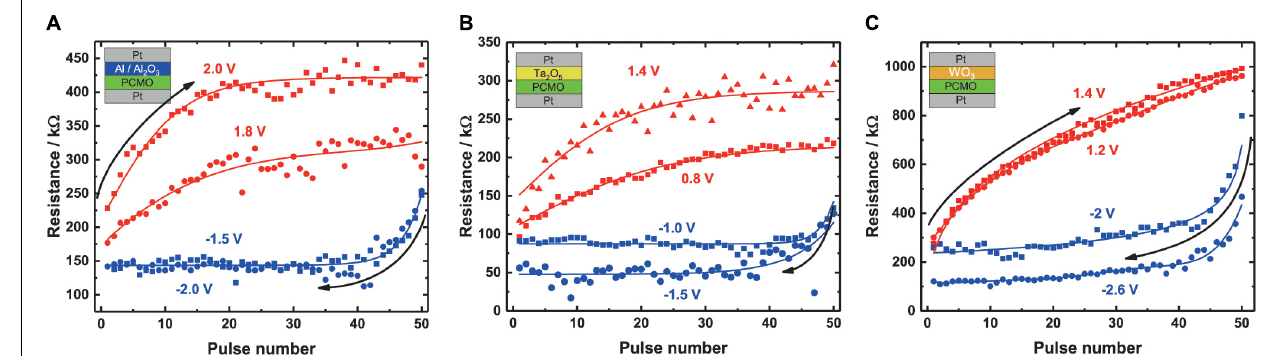
FIGURE 4 | Results of the SPM and RPM for the different devices. The RPM curve (red) and the SPM curve are plotted for the same material into the same coordinate system. The SPM curve starts at higher pulse numbers and goes down to lower pulse numbers; the RPM curve can be read as normal. The pulse voltages for the different stacks can also be seen in Table 1 . (A) Al 2 O 3 , (B) Ta 2 O 5 , and (C) WO 3 . Every pulse has a length of 100 µ s. For the shown curves, the fits are shown in the